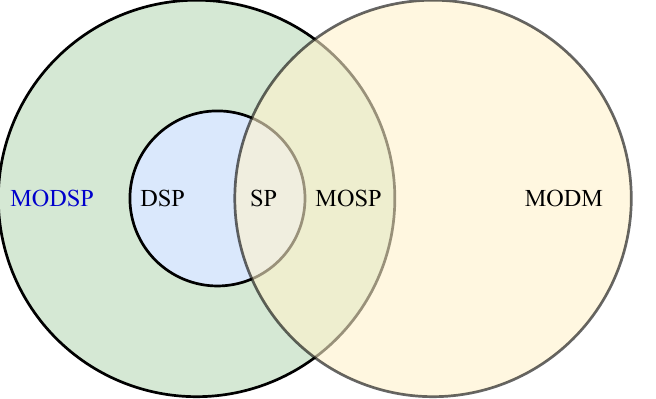
Figure 5. Venn diagram representing the taxonomy of the MODSP problem class and its relationship with the DSP, MOSP, SP, and MODM problem